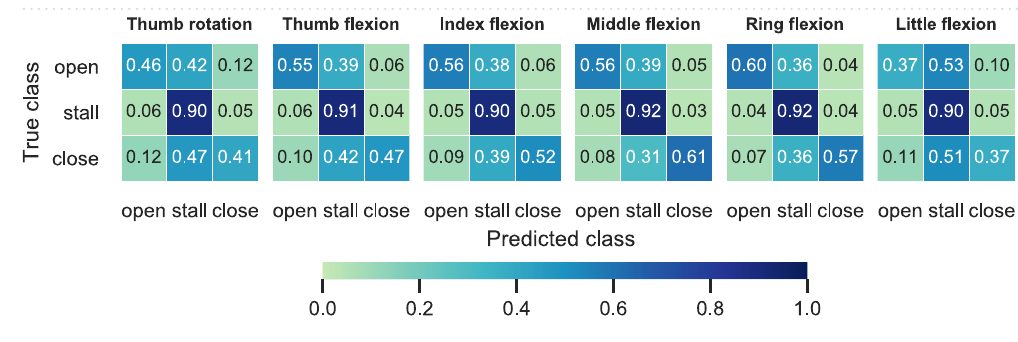
Figure 4. Confusion matrices. For each DOF, the average confusion matrices obtained with the independent multi-output RDA classifier are shown. Colour bar and annotated scores indicate normalised prediction